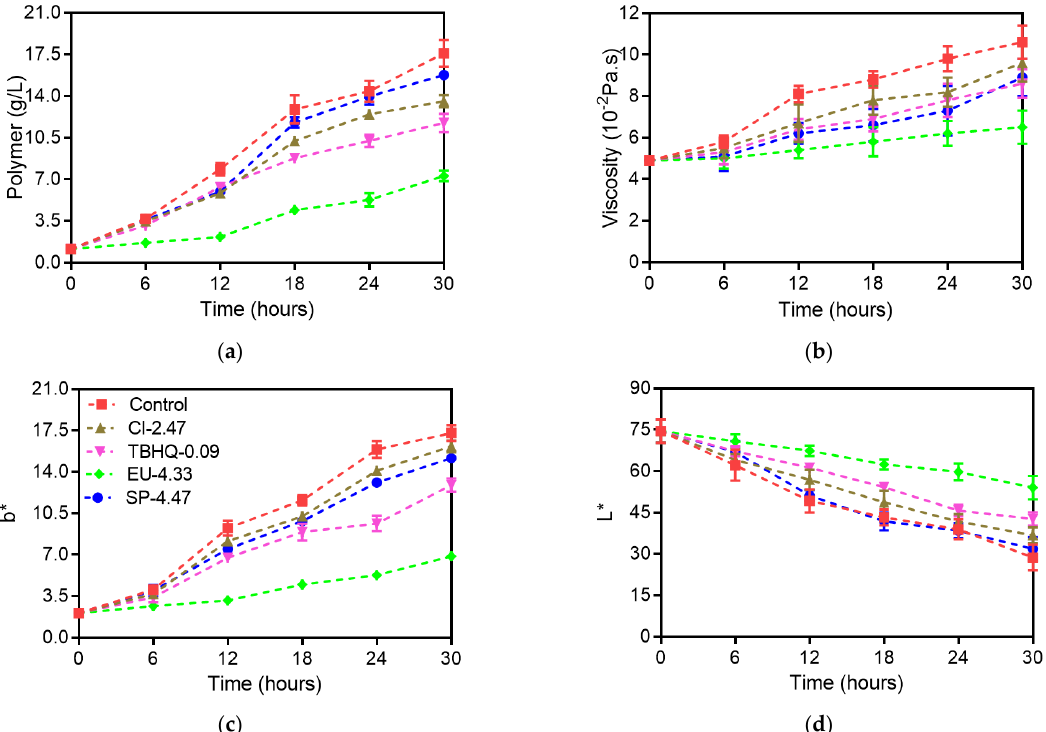
Figure 5. The values for the polymer ( a ), viscosity ( b ), b * ( c ), and L * ( d ) of sunflower oil added by nothing, 1,8-cineole (2.47 mg/kg, CL-2.47), TBHQ (0.12 g/kg, TBHQ-0.09), eugenol (4.33 mg/kg, EU-4.33), and spathulenol (4.47 mg/kg, SP-4.47) during the deep-frying of youtiao for 30 h. Values are expressed as mean ± SD (n = 10).